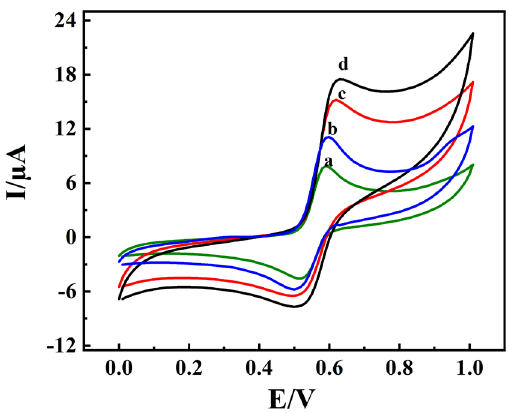
Figure 5. Electrochemical behaviors of 0.1 mmol/L 6,7-DHC on (a) SPE, (b) ND/SPE, (c) BP/SPE and (d) ND@BP/SPE in pH 3.0 PBS at the scan rate of 100 mV/s. The effect of different scan rates on the redox process of 0.1 mmol/L 6,7 − DHC was investigated in the range from 50 to 1000 mV/s on ND@BP/SPE; the results are shown in Figure S2A. As the scan rate increased, the redox peak currents and potential gradually